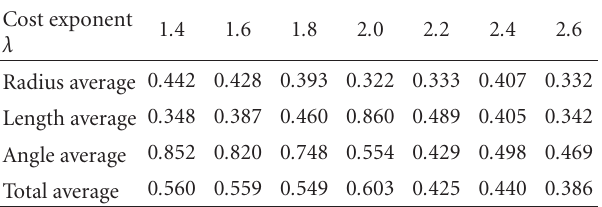
Table 5: The best overall CCO results before postprocessing are achieved for a radius exponent λ = 2 . 0 in the cost function